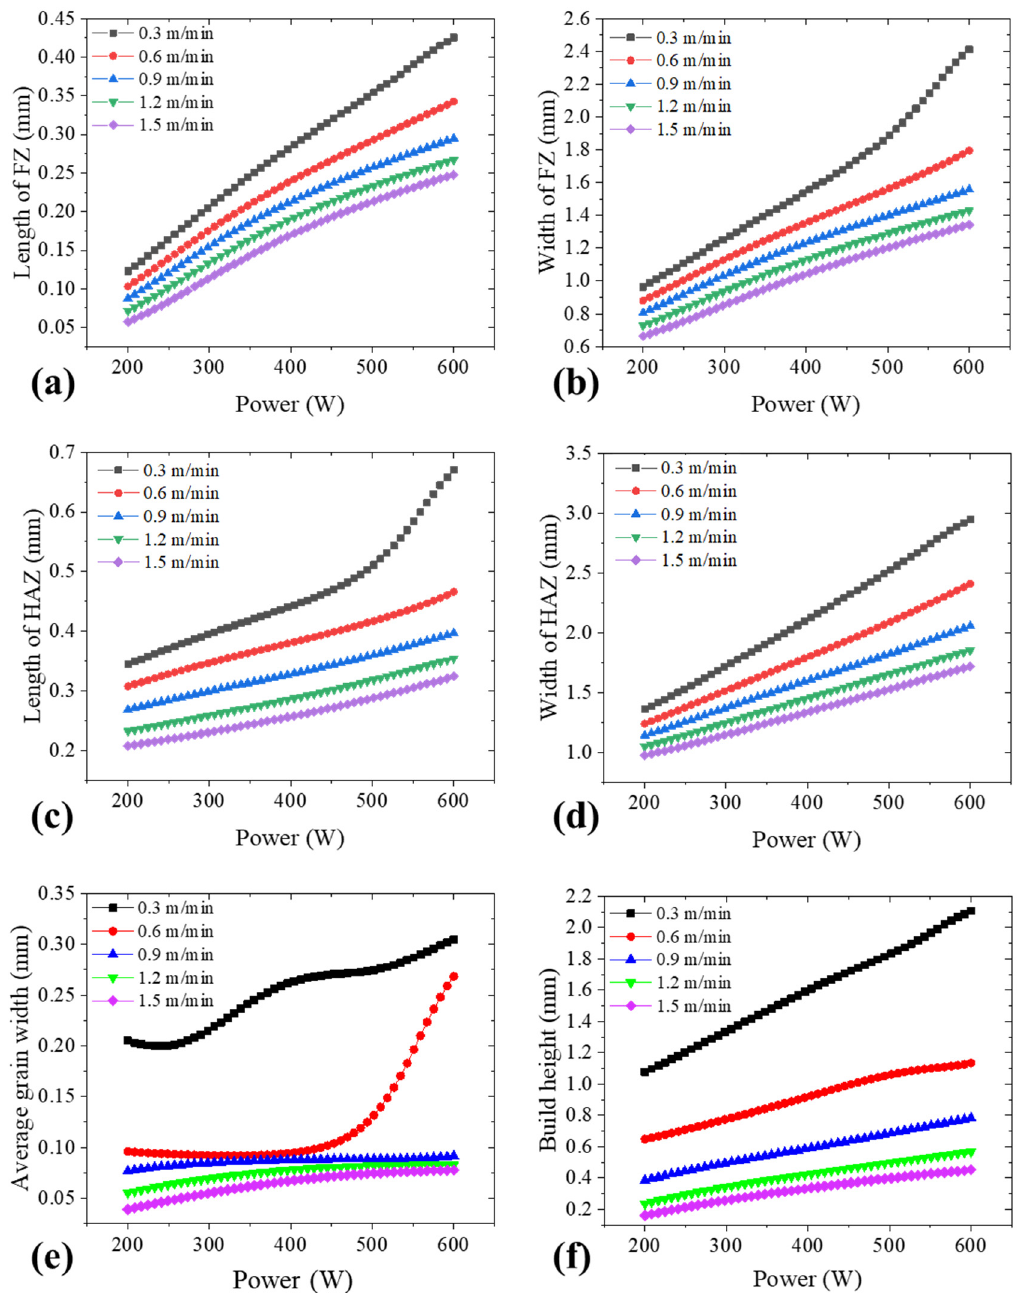
Figure 4. Estimated effect of the laser power on ( a ) the length of the fusion zone (FZ), ( b ) width of the FZ, ( c ) length of the heat-affected zone (HAZ), ( d ) width of the HAZ, ( e ) columnar grain size, and ( f ) build height of the direct energy deposition-processed Ti–6Al–4V alloy components at various scan speeds.